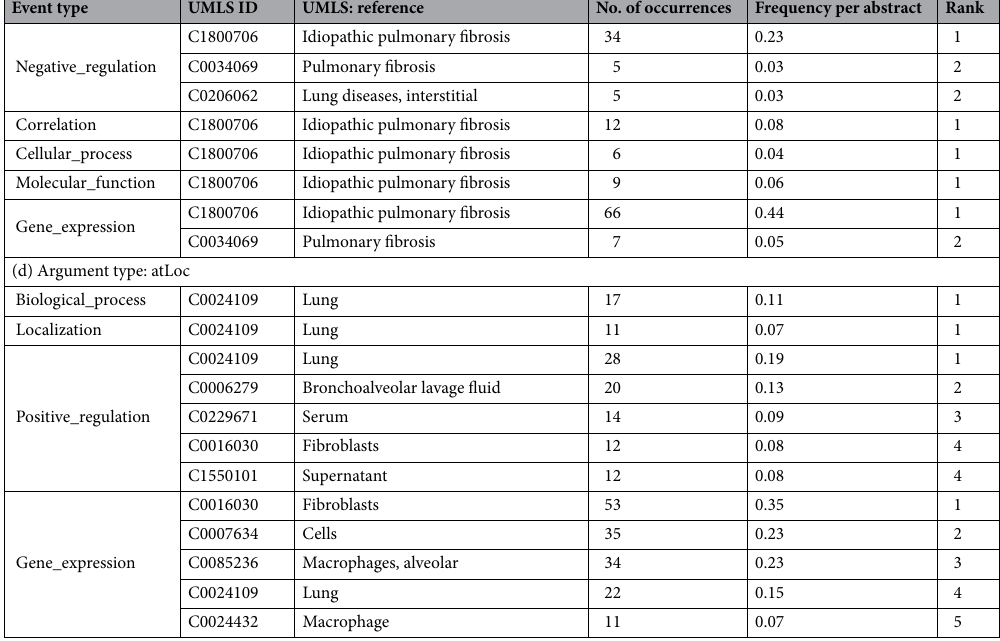
Table 7. Frequently observed UMLS IDs as arguments for each event type. Molecular entities for UMLS reference are presented in italic and in bold, whereas molecular events are shown in